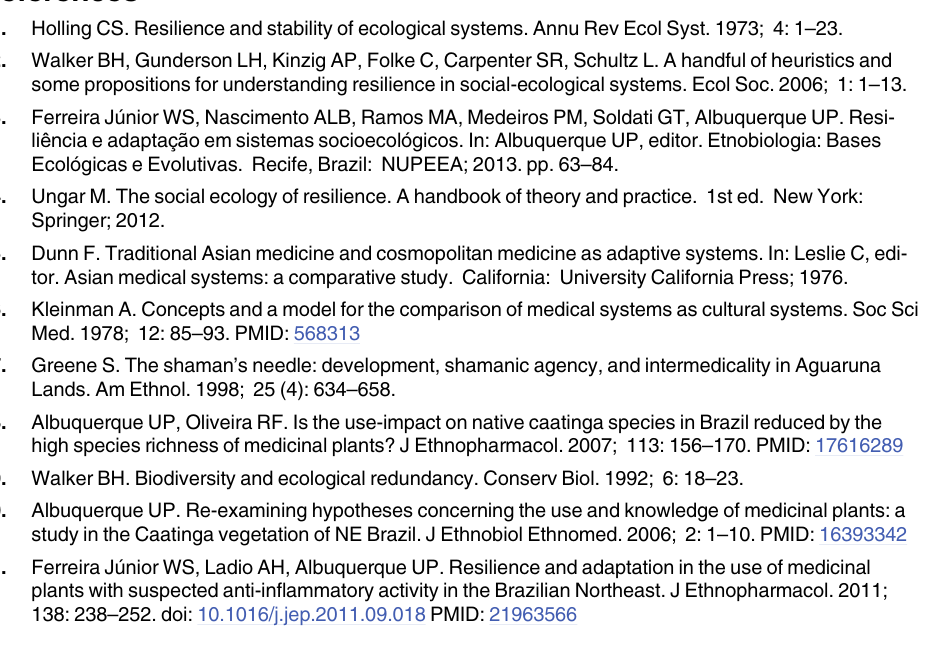
S1 Table. Cited therapeutic targets and their redundancy, frequency, perceived severity and medical system sharing levels for two rural communities in the semi-arid region of north- eastern Brazil. S2 Table. Description of cited therapeutic targets or their equivalent condition in Western